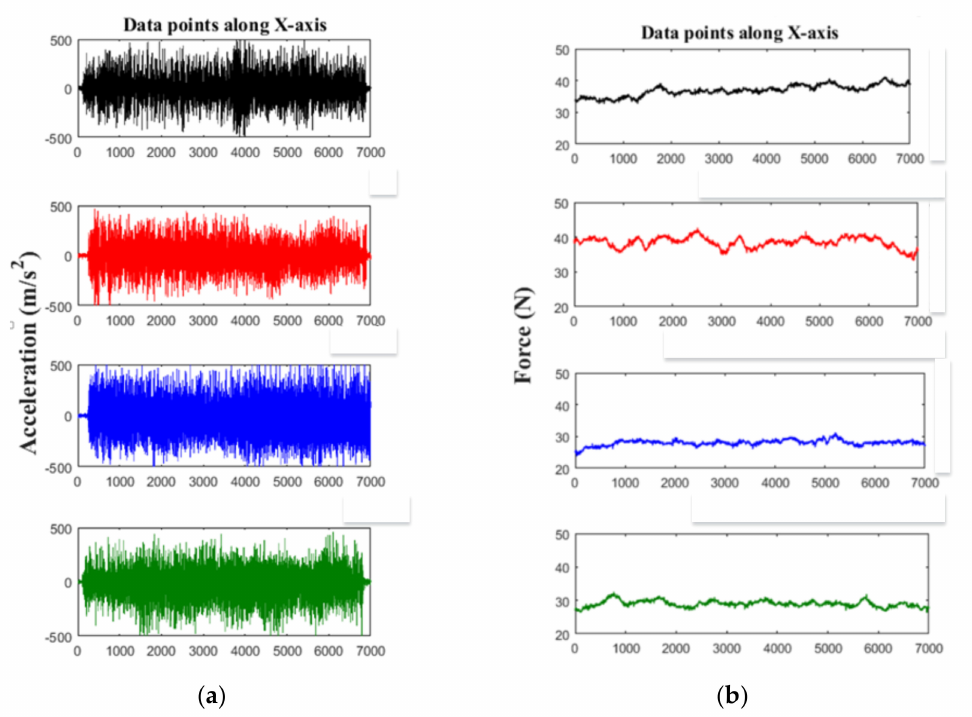
Figure 15. Raw signals of x-axis sensor direction: ( a ) vibration and ( b )